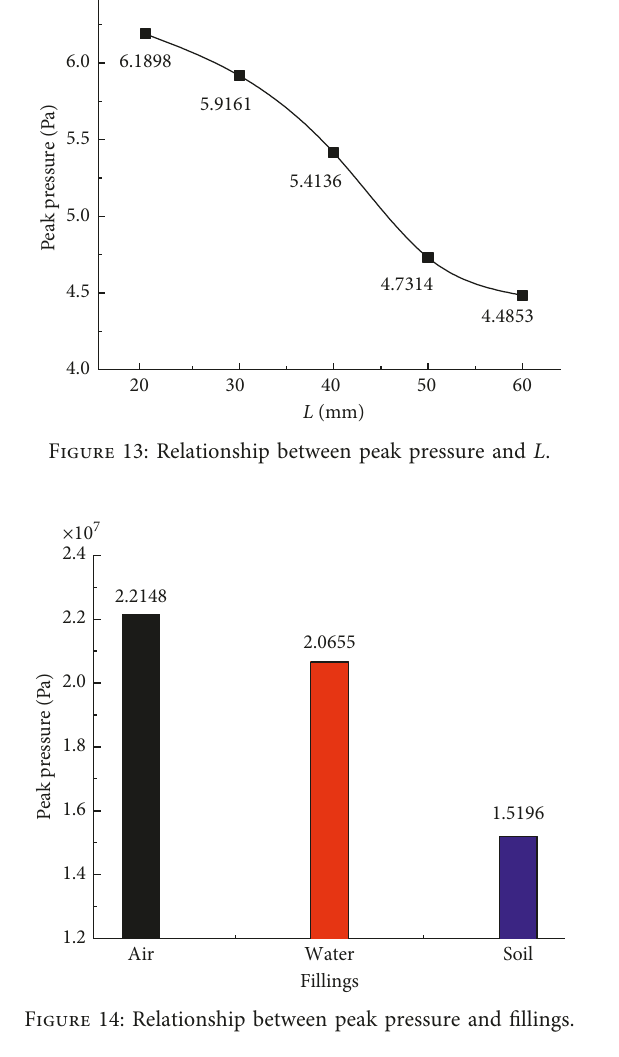
Figure 17: Typical curves of pressure-time at different angles (air- filled specimens at L �